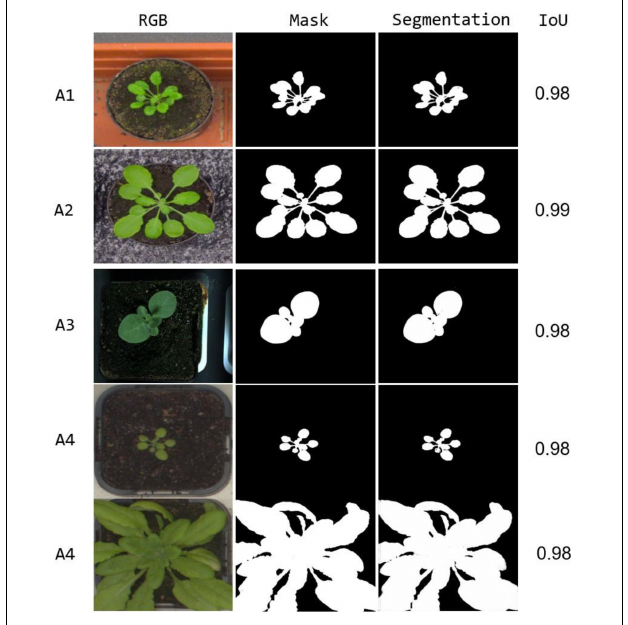
FIGURE 5 | Segmentation result for each sub-dataset, with the corresponding IoU provided at the right.